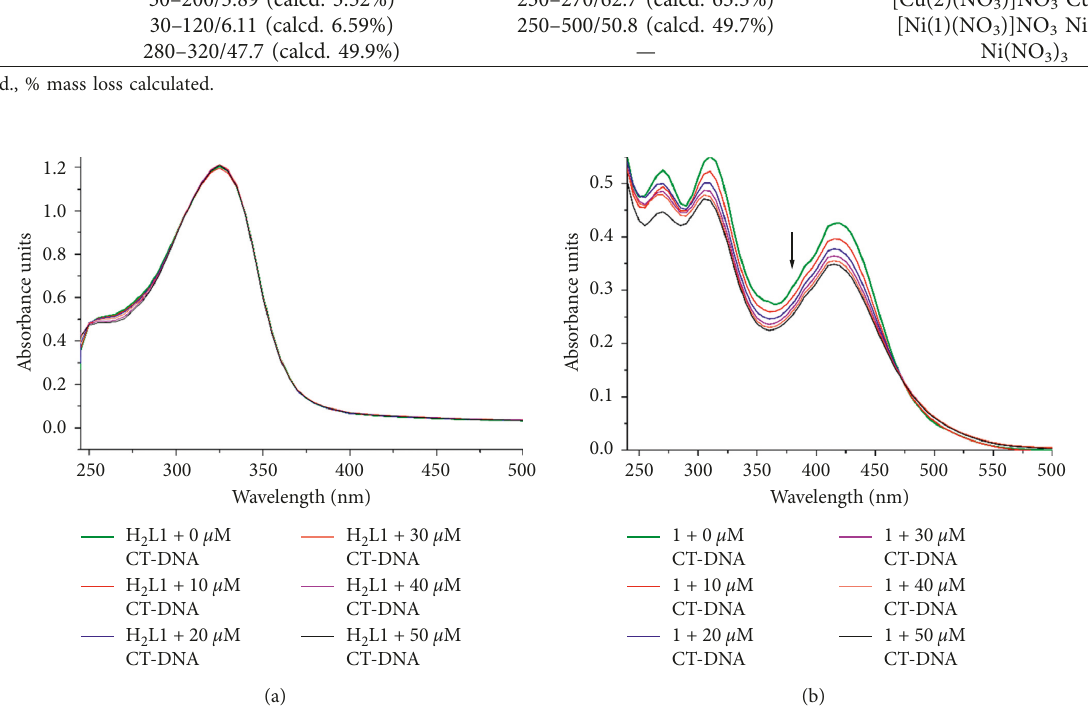
2 L1 ; (b) 1 (as a representative example) at a constant concentration of 20 μ mol · L L ·